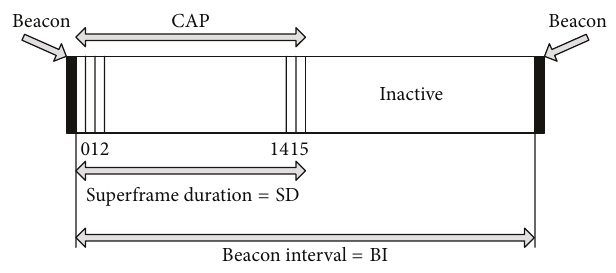
Figure 2: IEEE 802.15.4 superframe structure.